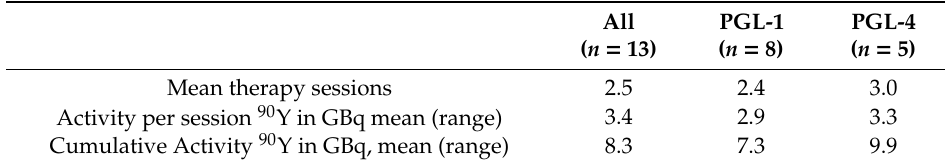
Table 4. Details of given activity in group all SDHx patients and additional in SDHD and SDHB